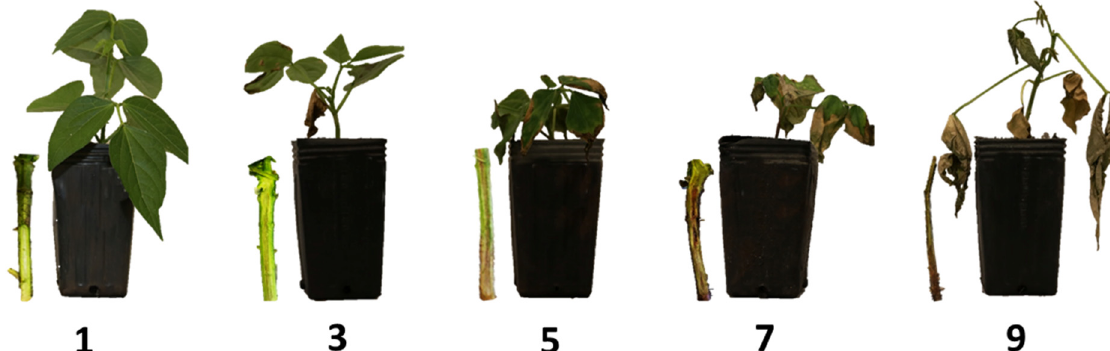
Figure 1. The DSR was measured according to an adapted scale [56], with values ranging from 1 to 9: score 1 = absence of symptoms and discoloration in the hypocotyl; score 3 = chlorosis, wilt, and restricted necrosis of the first leaves of the plant, with slight discoloration in the hypocotyl; score 5 = chlorosis, wilt, and necrosis in the leaves below the pointer and intermediate discoloration in the hypocotyl; score 7 = severe symptoms of generalized wilting throughout the plant, and dwarfism and severe discoloration in the hypocotyl; and score 9 = dead plant.